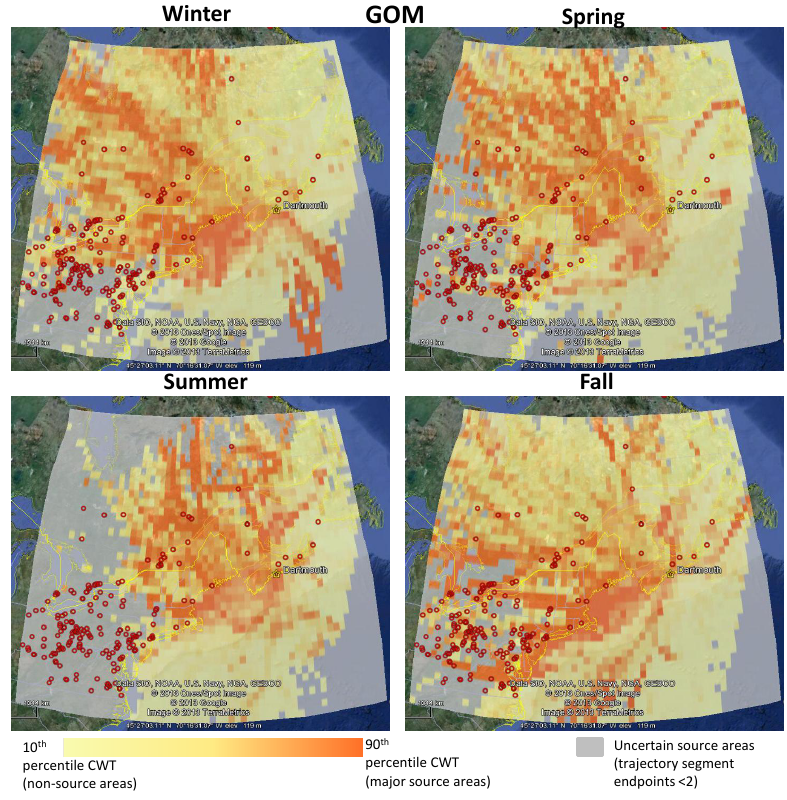
Fig. 5. Same as Fig. 4 except for